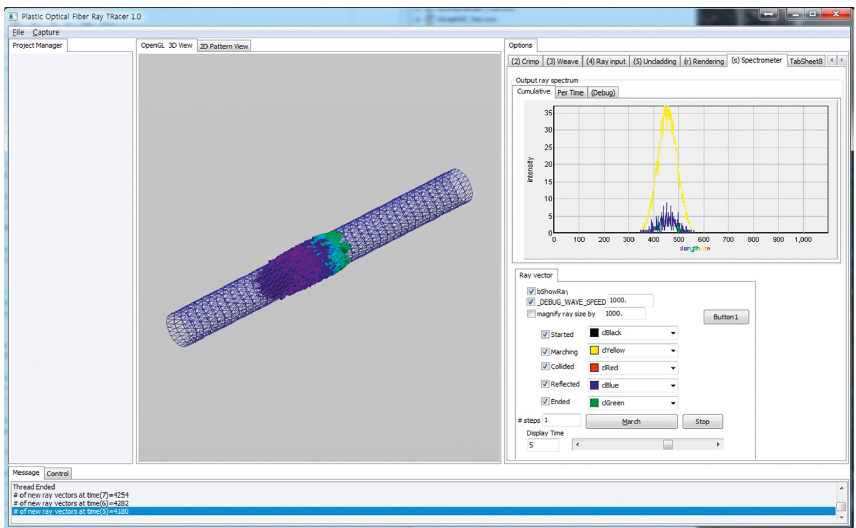
Figure 8: Screenshot of modeling software interface and ray vector marching (note that the vectors were temporarily exaggerated in length by 1000 times for demonstrational purpose).